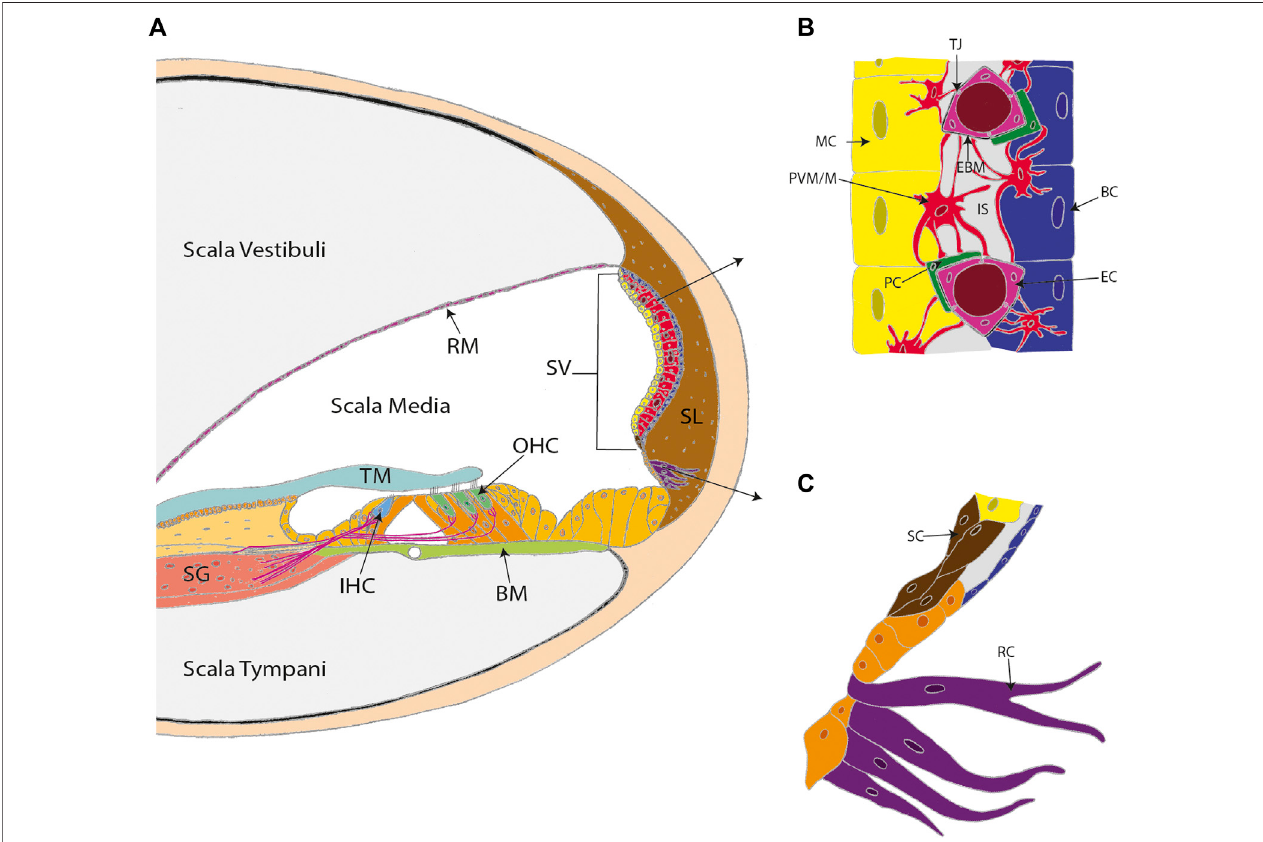
FIGURE 1 | The stria vascularis (SV) is a highly specialized and vascularized tissue lining the lateral wall of the cochlea. (A) A cross-section of the cochlea. (B) The threeconventionalcelllayersoftheSVincludethemarginalcelllayer(MC),theintermediatecelllayer,andthebasalcelllayer(BC).Themarginalcelllayerisexposedtothe endolymph and the basal cell layer interacts with spiral ligament fi brocytes. The intermediate cell layer is composed of perivascular-resident macrophage-like melanocytes (PVM/M), pericytes (PC), and endothelial cells (EC). The cell layers are tightly interlocked by infoldings and projections between the basolateral membranes of marginal cells and the PVM/Ms, and the PVM/Ms and the basal cells. (C) Other cell types in the lateral wall that contribute to SV function include spindle cells (SC) and root cells (RC). Other labels: Reisner ’ s membrane (RM); tectorial membrane (TM); spiral ganglion (SG); inner hair cell (IHC); outer hair cells (OHC); basilar membrane (BM); spiral ligament (SL); tight junctions (TJ); endothelial basement membrane (EBM) and intrastrial space (IS). (C) adapted from Gu et al. (2020).